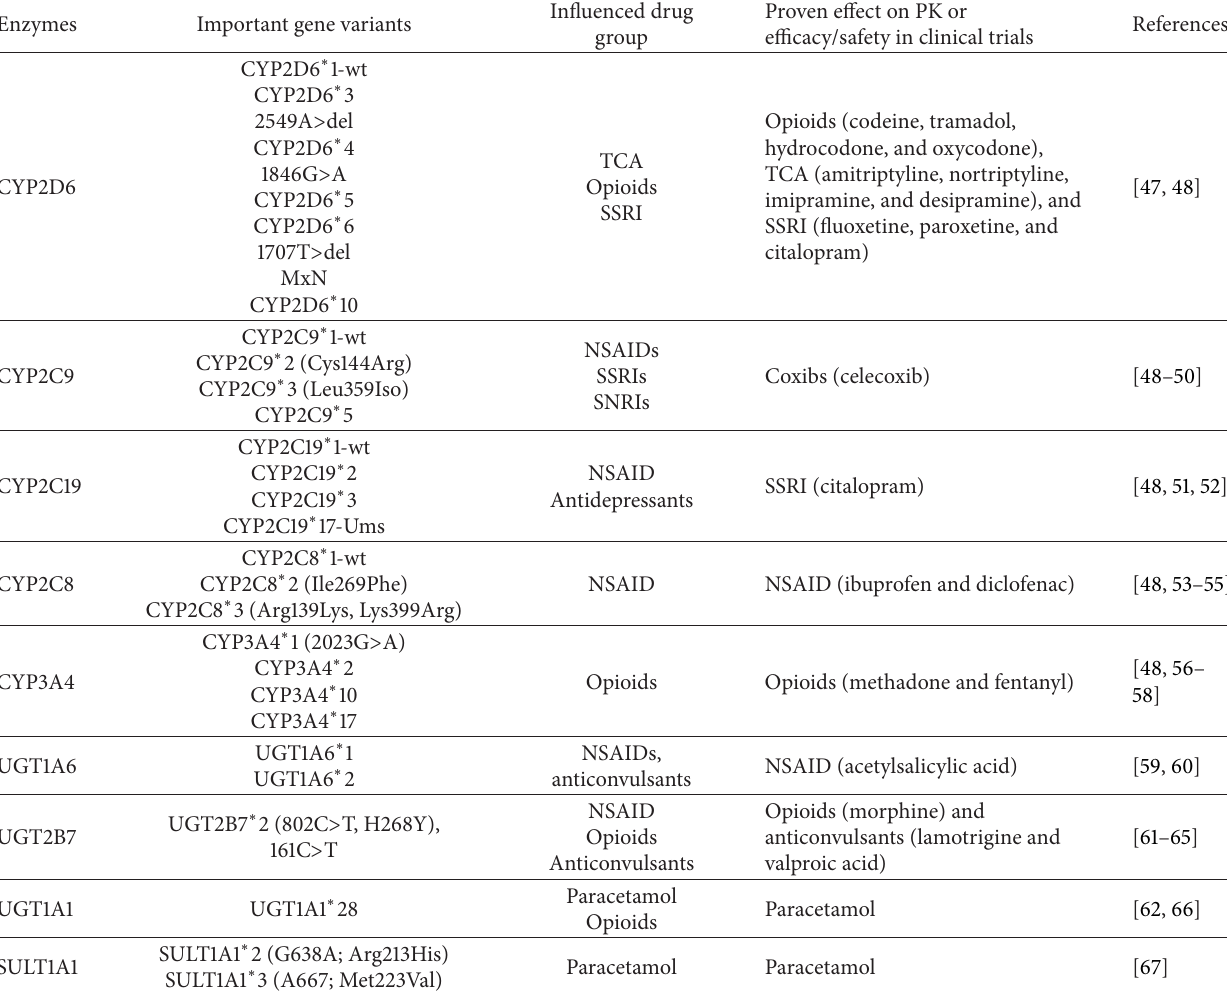
Table 4: The principal polymorphic DMEs involved in the metabolism of drugs used for chronic pain.